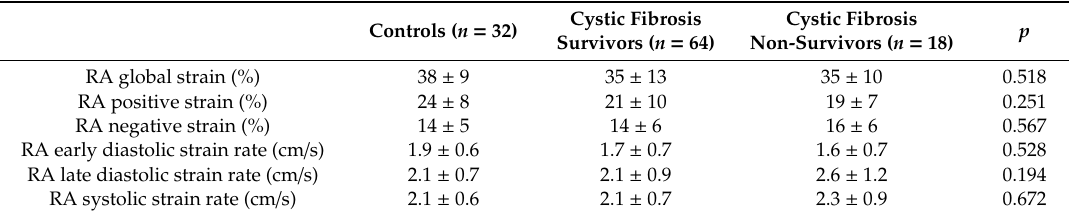
Table 4. Right atrial speckle tracking